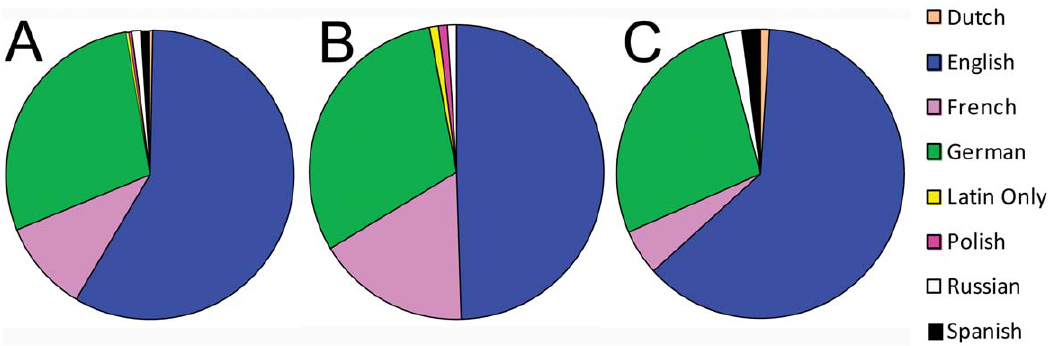
Figure 2. Proportion of Gymnodinium original species descriptions written in different languages. A) Proportion of original species descriptions in each language across the entire genus. B) Proportion of original species descriptions in each language for oncers. C) Proportion of original species descriptions in each language for species that have been observed since their original description.